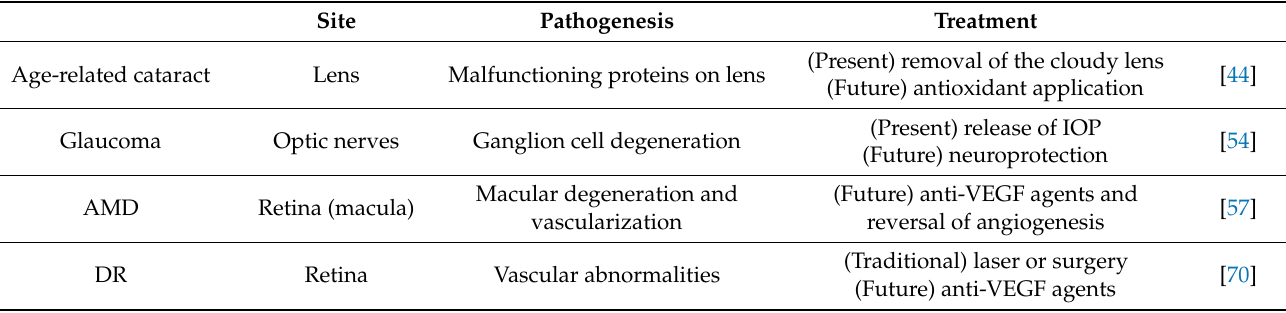
Table 1. Sites, pathogenic mechanisms, and main treatment strategies for the four ophthalmic conditions discussed in this review.